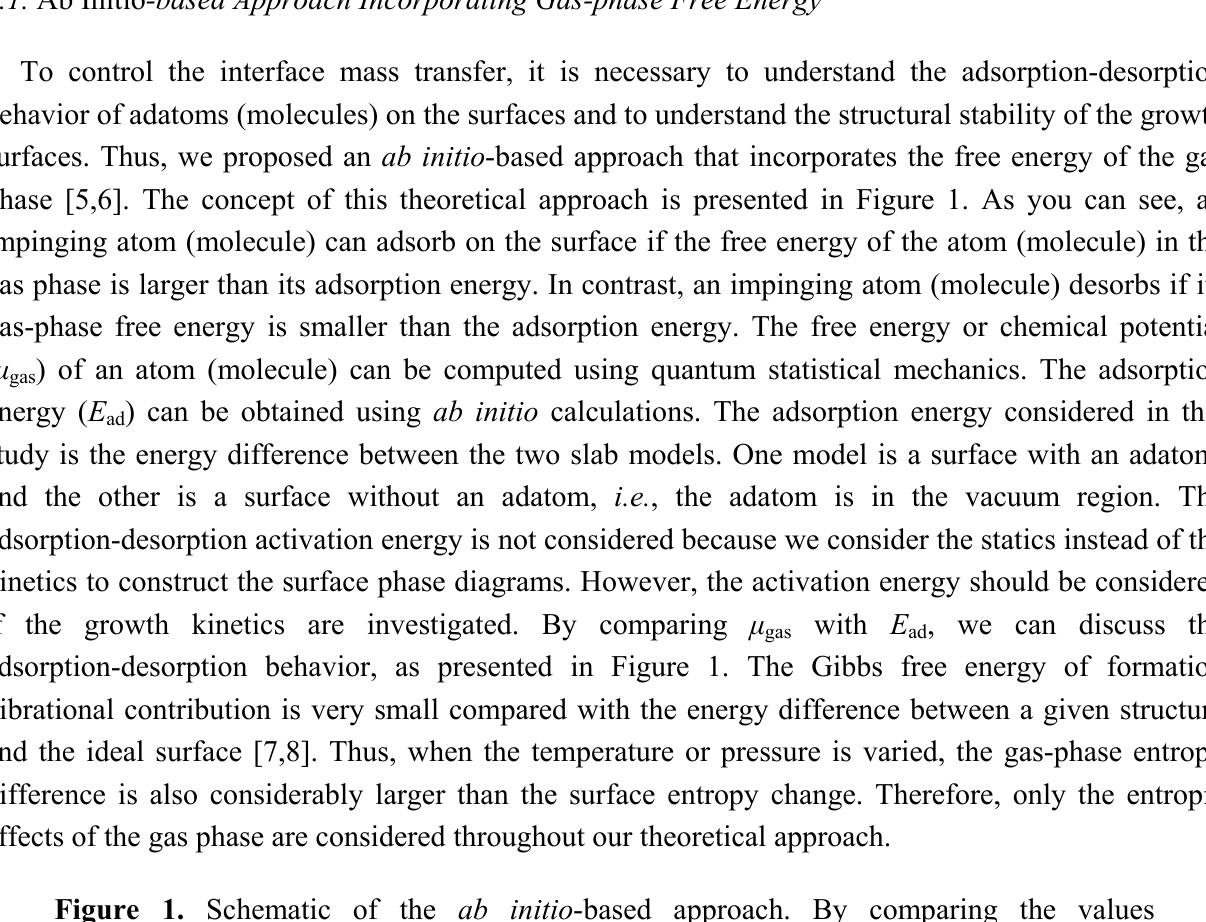
Figure 1. Schematic of the ab initio -based approach. By comparing the values , with adsorption energy, E , we can discuss the of the chemical potential, μ gas ad adsorption-desorption behavior of an adatom (a